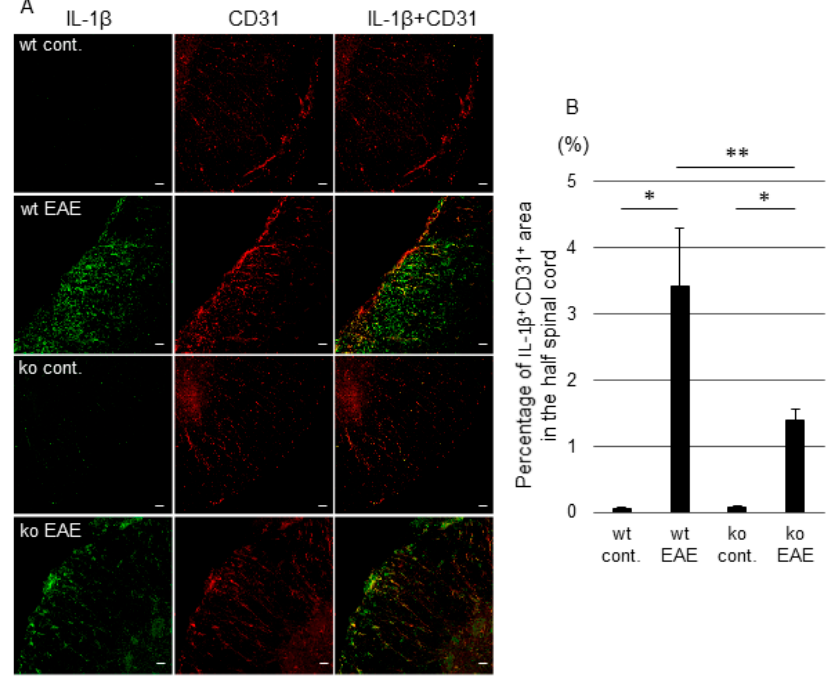
Figure 4. Expression of interleukin-1 β (IL-1 β ) in CD31-positive (CD31 + ) endothelial cells (ECs) in the spinal cords of control and experimental autoimmune encephalomyelitis (EAE) mice. Immunohistochemical images showing IL-1 β (green) and CD31 (red) in the spinal cords of wild-type (wt) control, wt EAE, microsomal PGE synthase-1-deficient ( mPGES-1 − / − ) control, and mPGES-1 − / − EAE mice ( A ). Percentage of IL-1 β -positive (IL-1 β + ) CD31 + area in half of the spinal cord per half of the spinal cord area ( B ). Scale bars are 20 µ m; wt, wild-type; ko, mPGES-1 − / − ; cont., naïve mice; EAE, EAE mice. * p < 0.001, ** p < 0.05.